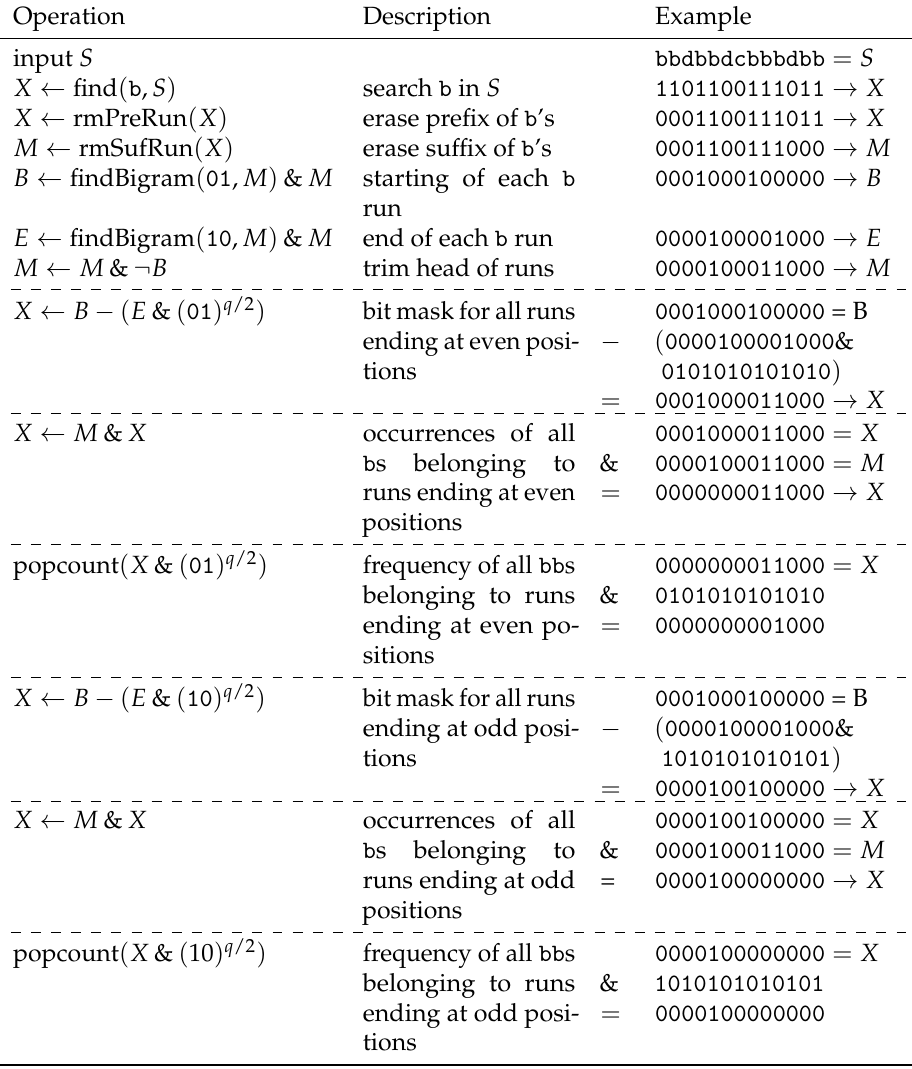
Figure 5. Finding a bigram bb in a string S of bit length q , where q is the largest multiple of 2 (cid:100) lg σ (cid:101) fitting into a computer word, divided by (cid:100) lg σ (cid:101) . In the example, we represent the strings M , B , E , and X as arrays of integers with bit width x : = (cid:100) lg σ (cid:101) and write 1 and 0 for 1 x and 0 x ,